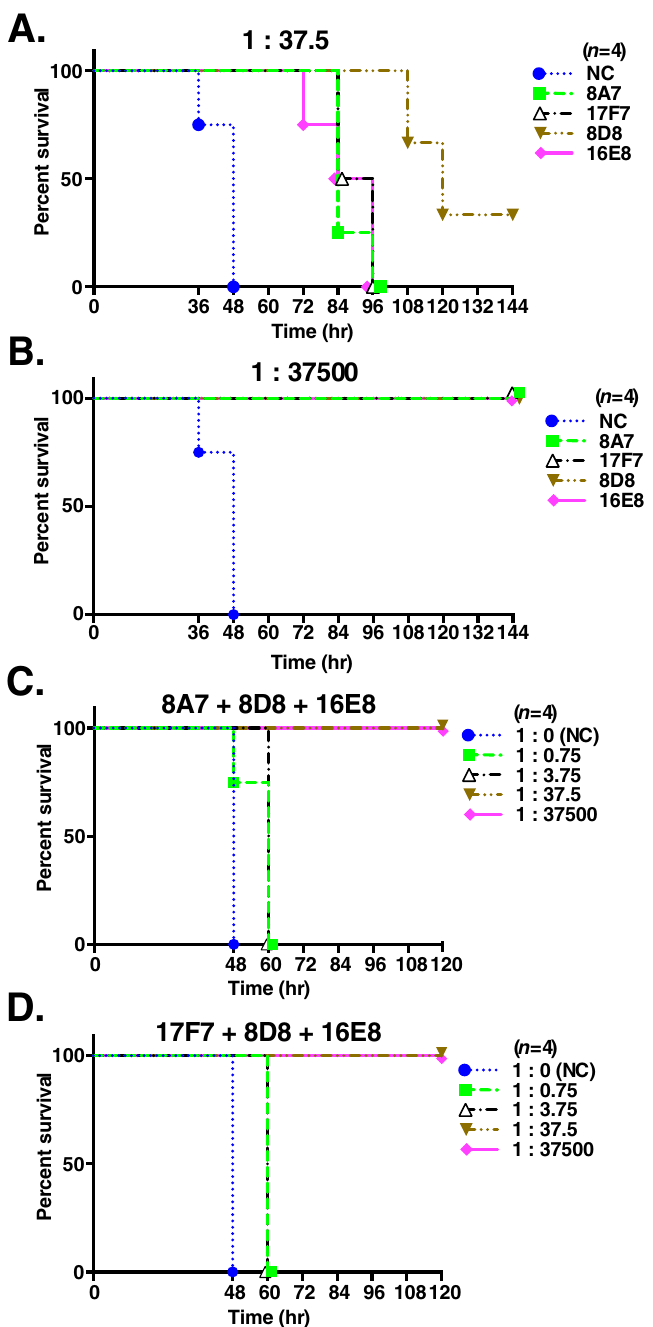
Figure 4. Mixing antibodies reactive to different domains completely protect the mice from TeNT. The TeNT- neutralization ability of purified recombinant 8A7, 17F7, 8D8, and 16E8 antibody clones were analyzed by an in vivo TeNT-neutralization assay. 1 LD 50 (25 pg) of TeNT was used for the assay. ( A , B ) 3.75 ng (TeNT:rAb ratio 1:37.5) ( A ) or 3750 ng (TeNT:rAb ratio 1:37,500) ( B ) of each antibody was assessed. ( C , D ) The protective ability of the combination of 8A7, 8D8, and 16E8 antibodies ( C ) or 17F7, 8D8, and 16E8 antibodies ( D ) was analyzed. TeNT:rAb ratios of 1:0.75, 1:3.75, 1:37.5, and 1:37,500 were analyzed. Mouse survival rates following administration are shown ( n = 4). NC negative control (PBS). Statistical analysis was performed using Log-rank